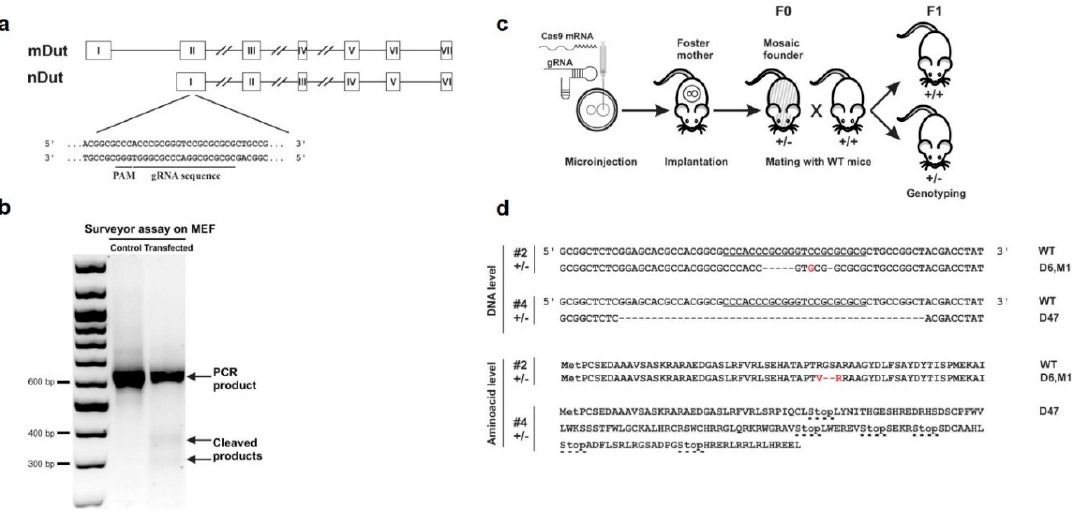
Figure 1. Generation and assessment of CRISPR knock-out mice. ( a ) Schematic diagram of the dut gene encoding the nuclear (nDut) and mitochondrial (mDut) isoforms of deoxyuridine 5 (cid:48) -triphosphate nucleotidohydrolase (dUTPase). Exons are indicated with Roman numerals in rectangles, introns are simplified as lines (for longer introns lines are broken). Guide RNA (gRNA) target site and protospacer-adjacent motif (PAM) sequence in the first common exon of the two isoforms are underlined. ( b ) Surveyor assay performed on mouse embryonic fibroblast (MEF) cells used for the detection of indel events induced by transfection with CRISPR gRNA and Cas9 mRNA. The two lower fragments indicate cleavage of the DNA due to CRISPR activity. These are lacking in the control while they are visible in the transfected sample. ( c ) Schematic diagram showing the generation of CRISPR-targeted knock-out mice. Fertilized oocytes microinjected with gRNA and Cas9 mRNA were implanted into foster mothers. The resulting founders (F0) #2 and #4 were cross-bred with wild-type (WT) mice to generate wild-type ( dut +/+) and heterozygous ( dut +/ − ) offspring (F1) containing the targeted locus through germline transmission. ( d ) DNA and predicted amino acid sequence of the two heterozygous founder mice (#2 and #4) showing CRISPR events, compared to the WT. Mouse #2 showed deletion of six nucleotides and a C to G mutation (D6, M1) resulting in the deletion of two amino acids and change of another two. In mouse #4, 47 nucleotides were deleted (D47) which resulted in a frameshift mutation leading to early stop codons indicated with dashed lines. CRISPR target site including PAM sequence is